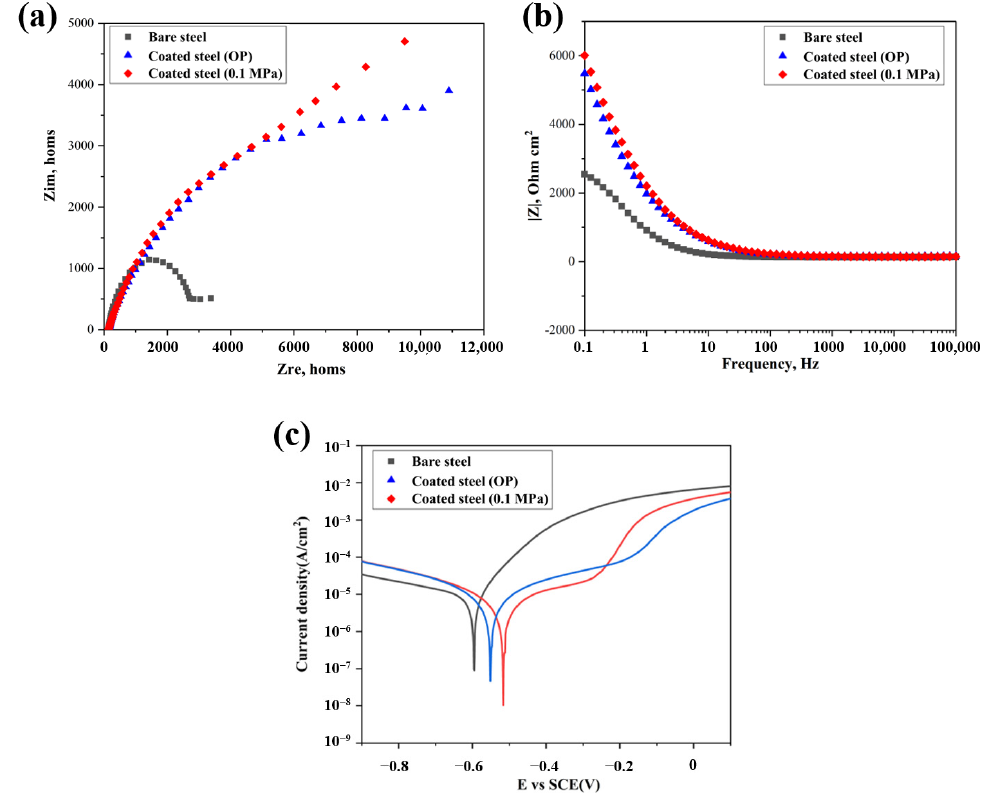
Figure 7. ( a ) Nyquist plots, ( b ) Bode plots and ( c ) Potentiodynamic polarization curves of bare steel substrate and coated steel substrate after carbonation.